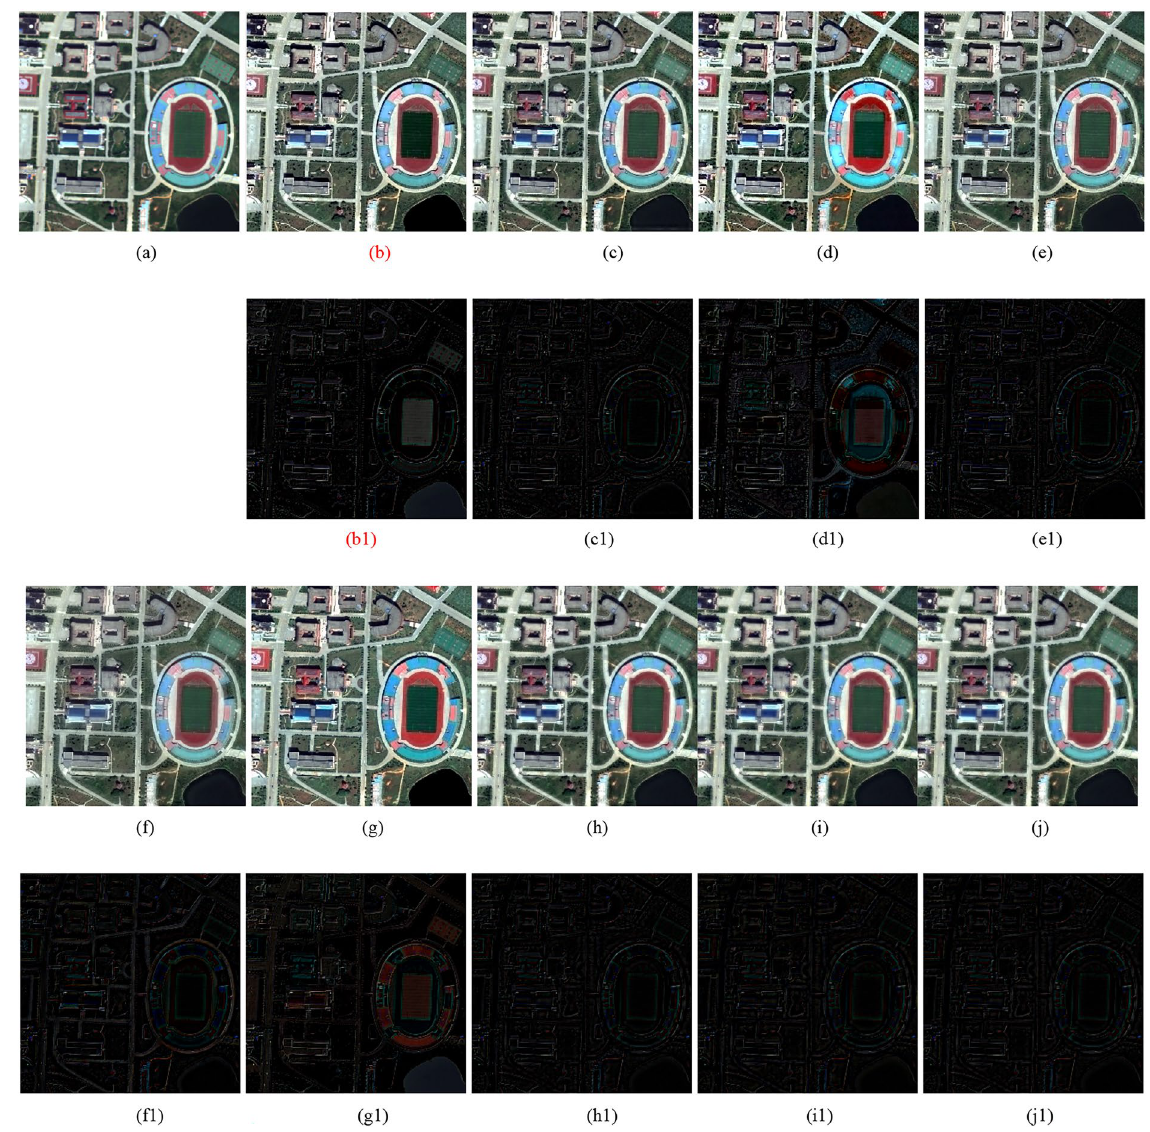
Figure 2. WorldView-2 images fusion results. ( a ) Ground truth. ( b ) GSA method. ( c ) CBD method. ( d ) BDSD method. ( e ) BF method. ( f ) MMMT method. ( g ) RBDSD method. ( h ) ASIM method. ( i ) DIM method. ( j ) Proposed method. ( b1 )–( j1 ) are the residual